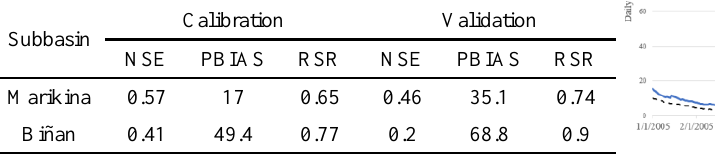
Table 7 . Calibration and Validation Results.